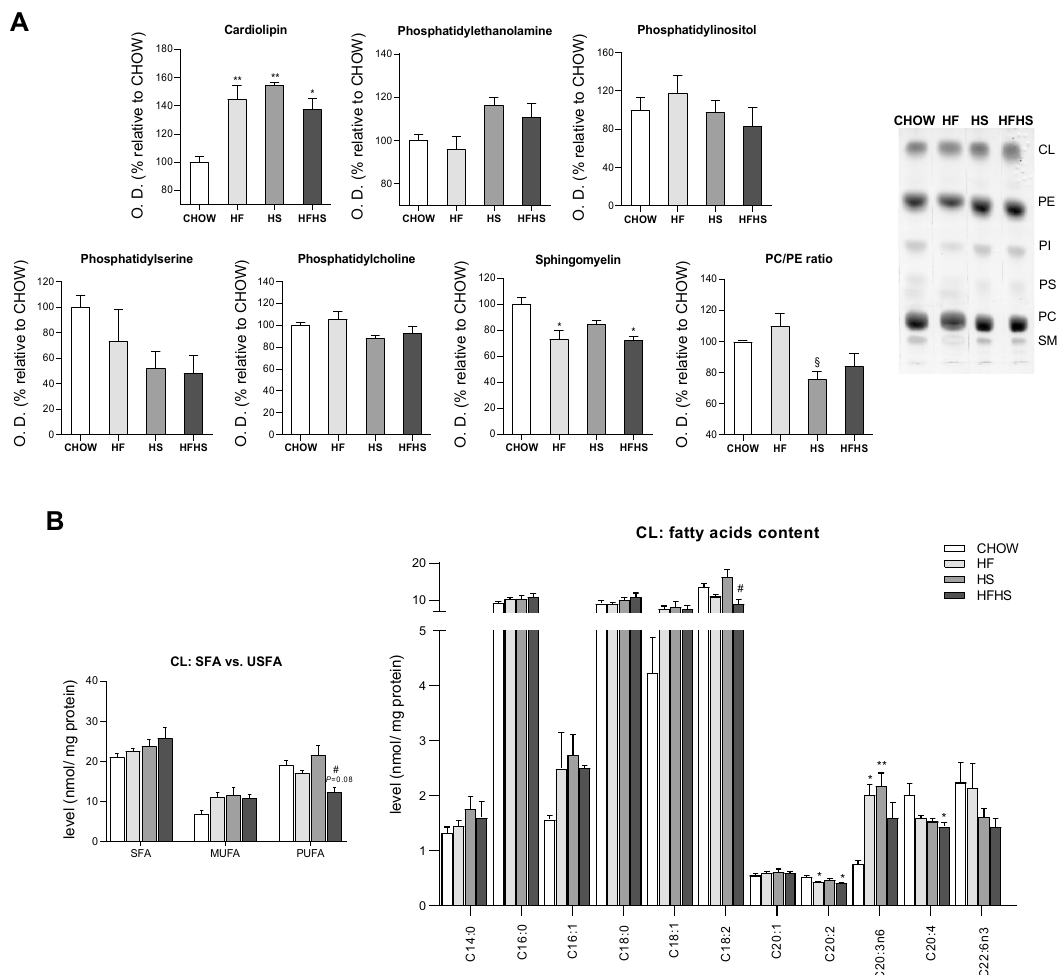
Figure 4. HF, HS and HFHS diets trigger mitochondrial phospholipid remodeling. ( A ) Optical density (arbitrary units) of mitochondrial content of CL, PE, PI, PS, PC and SM and the calculated PC / PE ratio. Representative thin-layer chromatography image of a replicate showing all phospholipid species ( N = 4). ( B ) CL content of SFAs, MUFAs and PUFAs in isolated hepatic mitochondria and detailed analysis of FA acyl chains in CL ( N = 4). All data are expressed as the mean ± SEM. (*) vs. the CHOW diet, (§) vs. the HF diet and (#) vs. the HS diet ( P < 0.05); (**) vs. the CHOW diet ( P < 0.01); P values were determined using one-way ANOVA followed by Bonferroni’s post hoc test or Kruskal–Wallis test followed by Dunn’s post hoc test. The purity of the mitochondrial fraction is shown in Figure 7D. CL, cardiolipin; HF, high-fat; HFHS, high-fat plus high-sucrose; HS, high-sucrose; PC, phosphatidylcholine; PE, phosphatidylethanolamine; PI, phosphatidylinositol; PS, phosphatidylserine; PUFA, polyunsaturated fatty acid; SFA, saturated fatty acid; SM, sphingomyelin; USFA, unsaturated fatty acid.